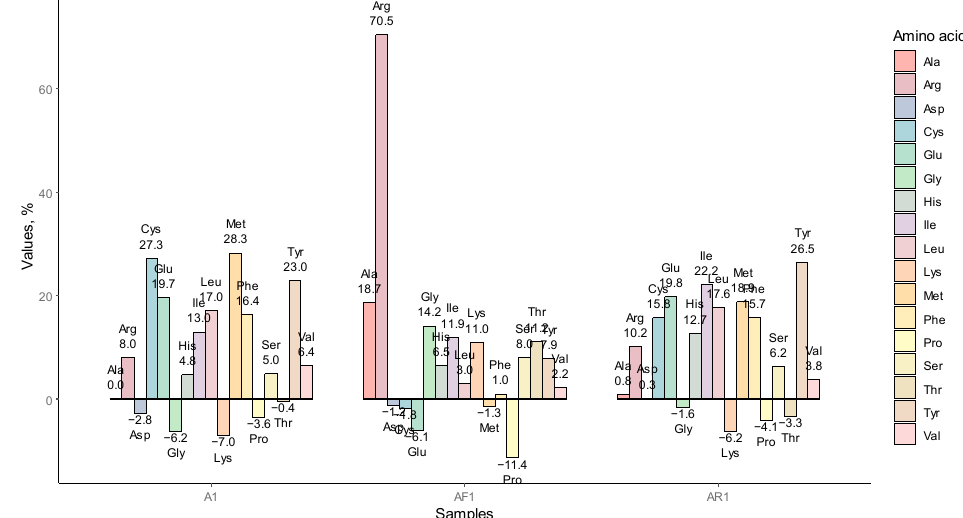
Figure 2. The percentage change of amino acid amounts in samples A1, AF1, and AR1, compared to initial oat material, oat flakes (FL1).